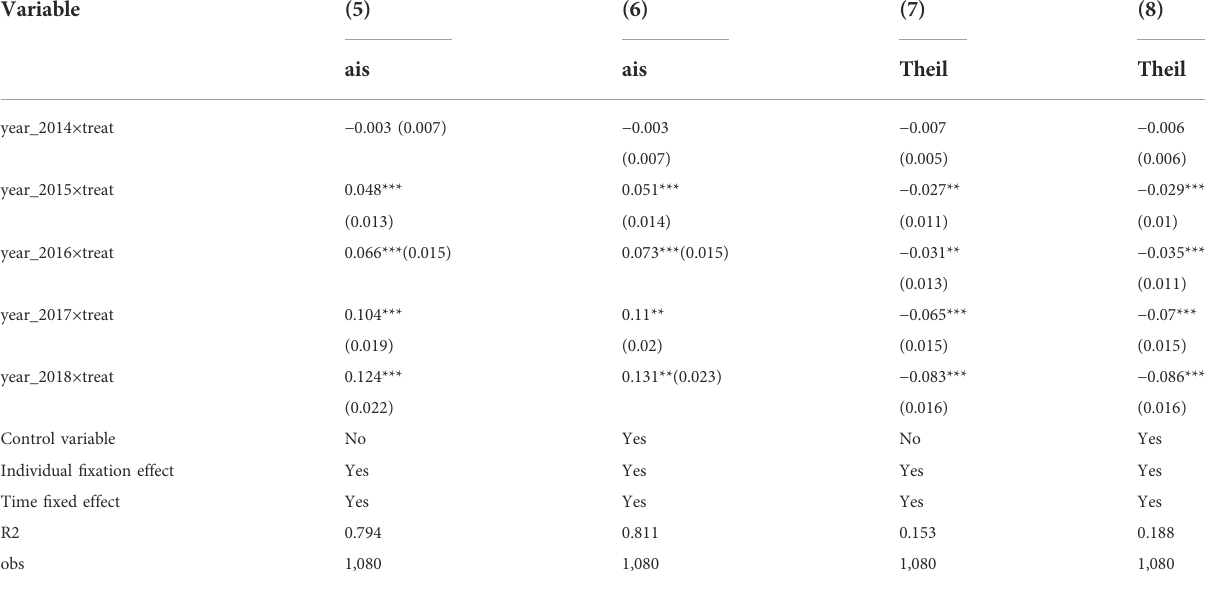
TABLE 5 Dynamic effects of the relocation and reconstruction policies for old industrial districts on the upgrading and rationalization of industrial structure. Variable